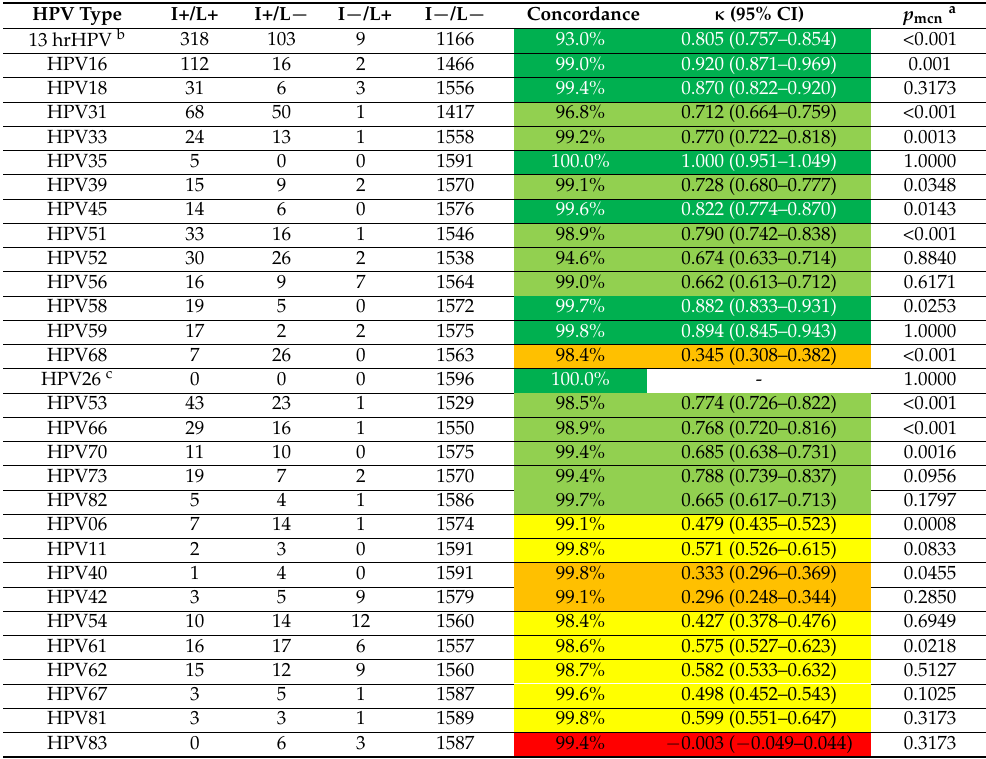
Table 4. Agreement (concordance and κ values) between the INNO-LiPA and the Linear Array for overall hrHPV positivity and for 29 individual HPV types common to both assays in the total study